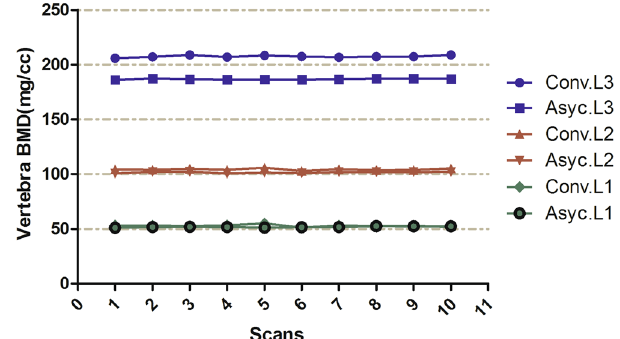
Figure 2. Ten-scan results of asynchronous and conventional quantitative computed tomography (QCT) for ESP study. Asyc., asynchronous QCT method; Conv., conventional QCT method.